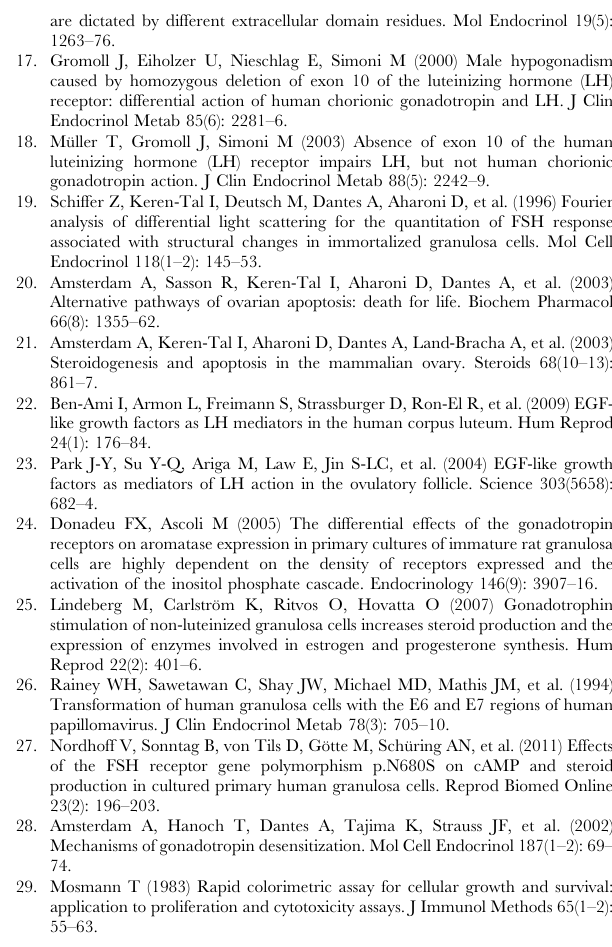
Figure S4 Intracellular cAMP production over 6 hours in hGLC stimulated by hLH (500 pM) or hCG (100 pM). Each value was normalized vs unstimulated. One representative experiment of two is shown. Figure S5 Control samples of immunofluorescence analysis. Non -permeabilized cells control of LHCGR sequestra- tion from cell surface in hLH-treated hGLC, after 15 hours. a. Unstimulated cells. b. hLH-treated hGLC. LHCGR is labeled in red (Tritc), the cytoplasmic marker ERK1/2 in green (Fitch) and cell nuclei marker (DAPI) in blue. The merging of the three images is in the lower right plate of each panel. Images are from one experiment and are representative of three independent experi- ments with similar results. c. Western blot control for anti- LHCGR antibody performed on 1) COS7/LHCGR cell lysates; 2) hGL5/LHCGR cell lysates; 3) Untrasfected hGL5 cell lysates (negative control); 4) and 5) hGLC cell lysates from two different donors. Figure S6 Comparison between recombinant and ex- tractive gonadotropin effect on ERK1/2 and AKT phosphorylation. Dose-response experiment evaluating the